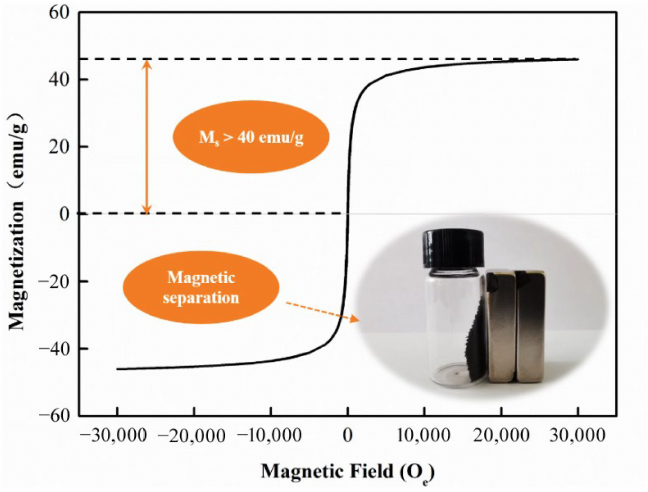
Figure 2. VSM analysis of